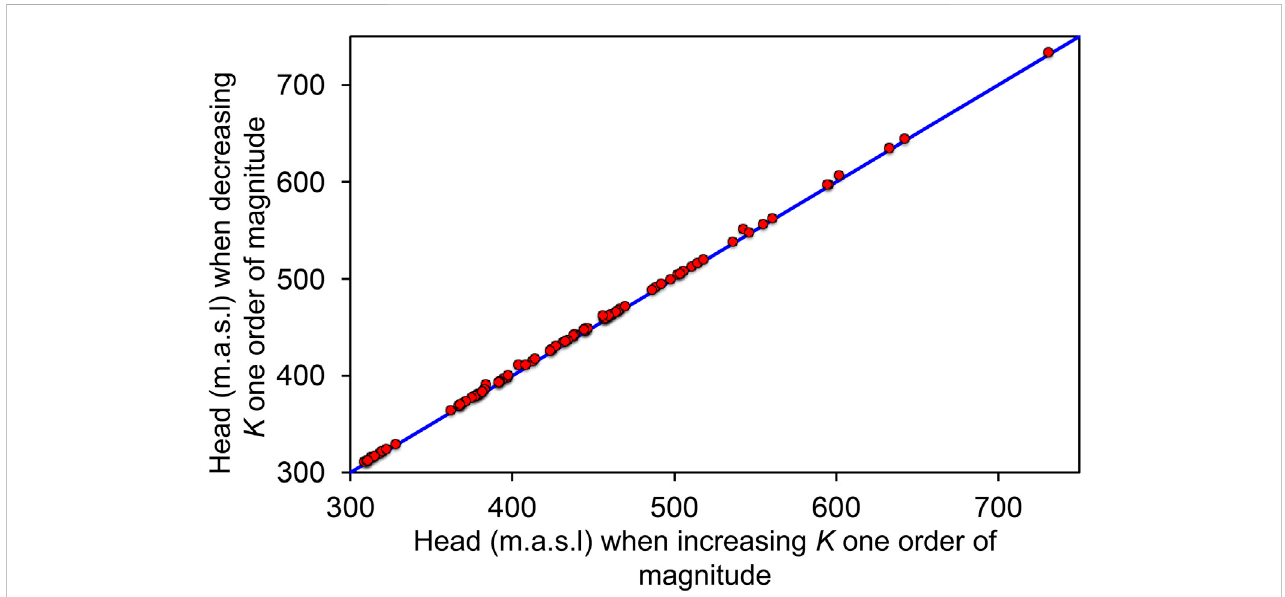
FIGURE 6 Linear regression plot between the steady state piezometric head computed with two numerical models whose values of K differ in two orders of magnitude. Piezometric head is computed at observation points used to calibrate the model. Only observation points representing piezometers screened in shallow aquifers are considered (i.e., 96 piezometers).